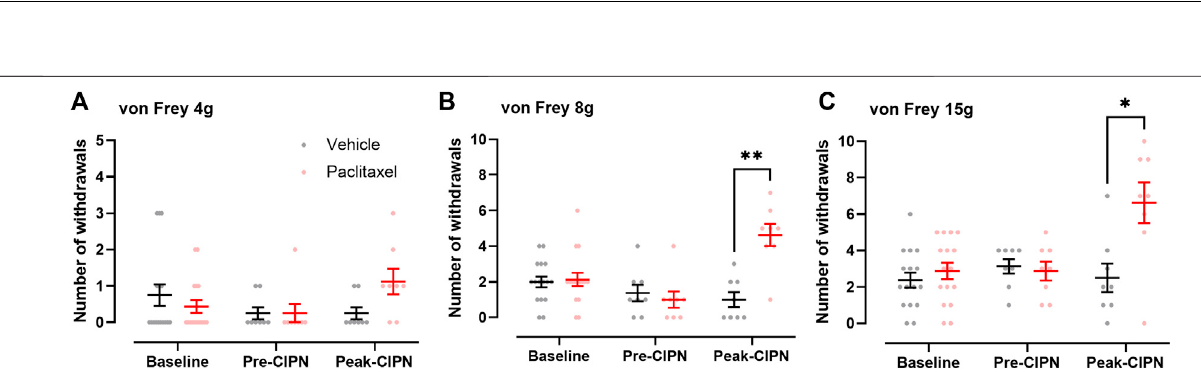
Frontiers in Pharmacology |